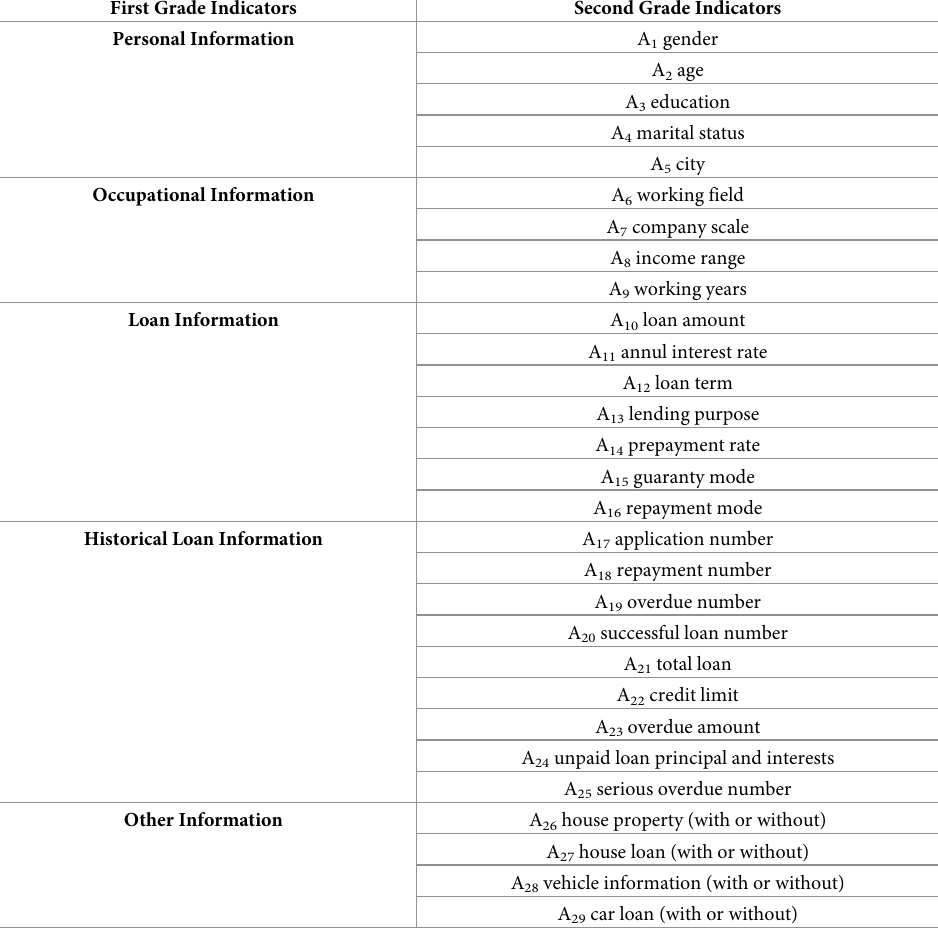
Table 1. P2P lending borrower credit risk assessment